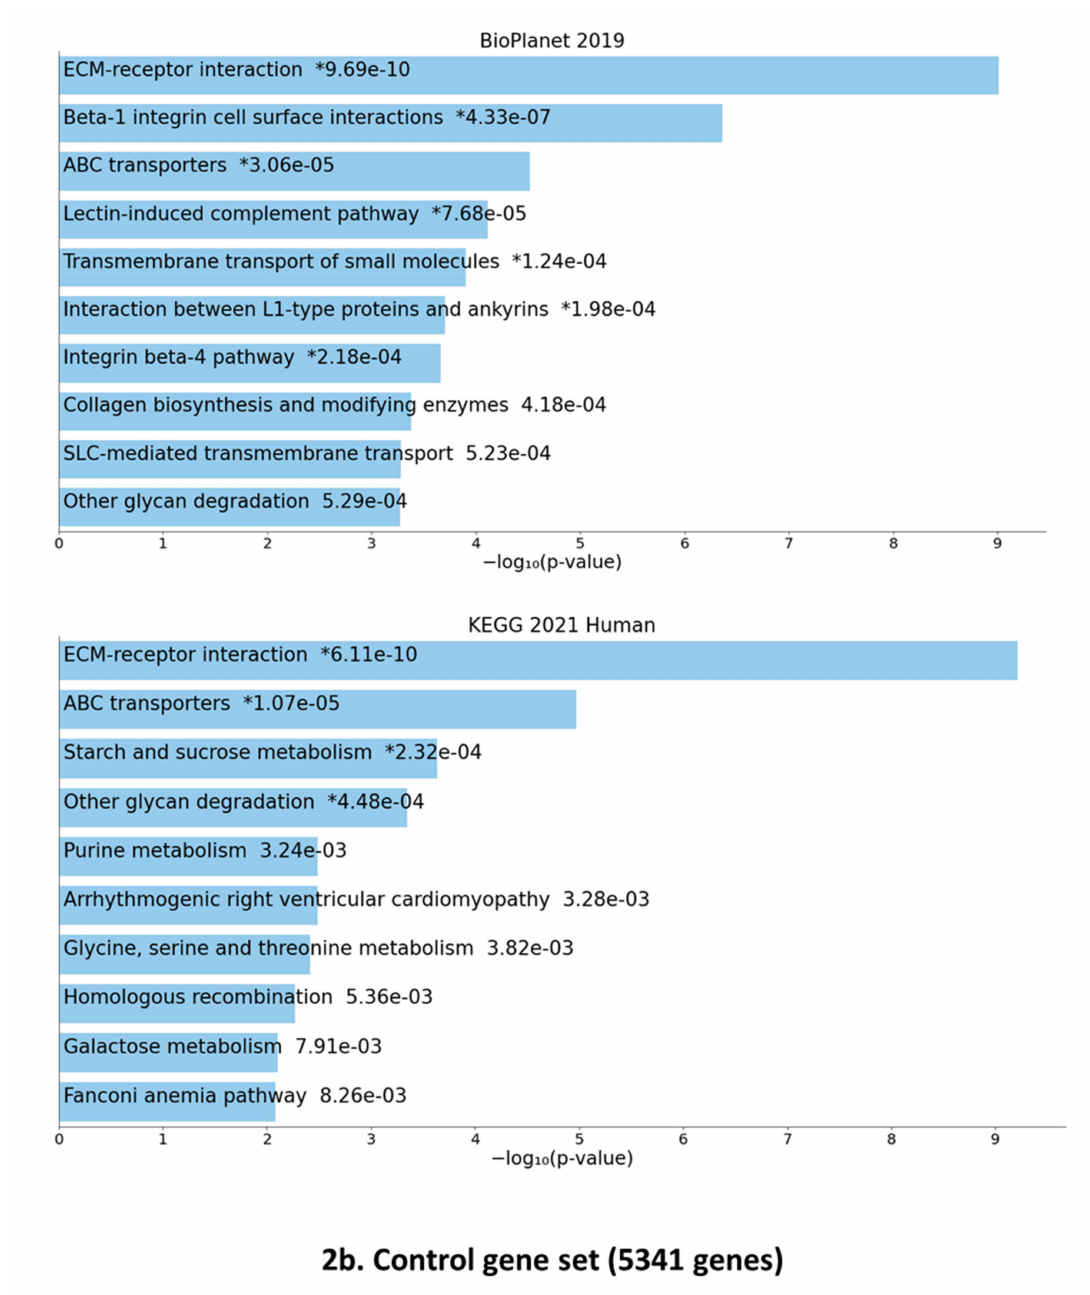
Figure 2. Disease-based enrichment analysis through the ENRICH.R web server [20–22]. Gene set enrichment analysis of the top 10 genes obtained through BIOPLANET-2019 (NIH-USA, National Center for Advancing Translational Science) and KEGG-2019 (Kyoto Encyclopedia of Genes and Genomes) pathway analysis on all of the deleterious variant carrying genes of F-SARC ( a )—329 genes selected in familial sarcoidosis) and CTRL ( b )—5341 genes selected in controls) series. The bar chart shows the top 10 enriched terms in the chosen library, with their corresponding p -values. Colored bars correspond to terms with significant p -values (<0.05). An asterisk (*) next to a p -value indicates the term also has a significant adjusted p -value